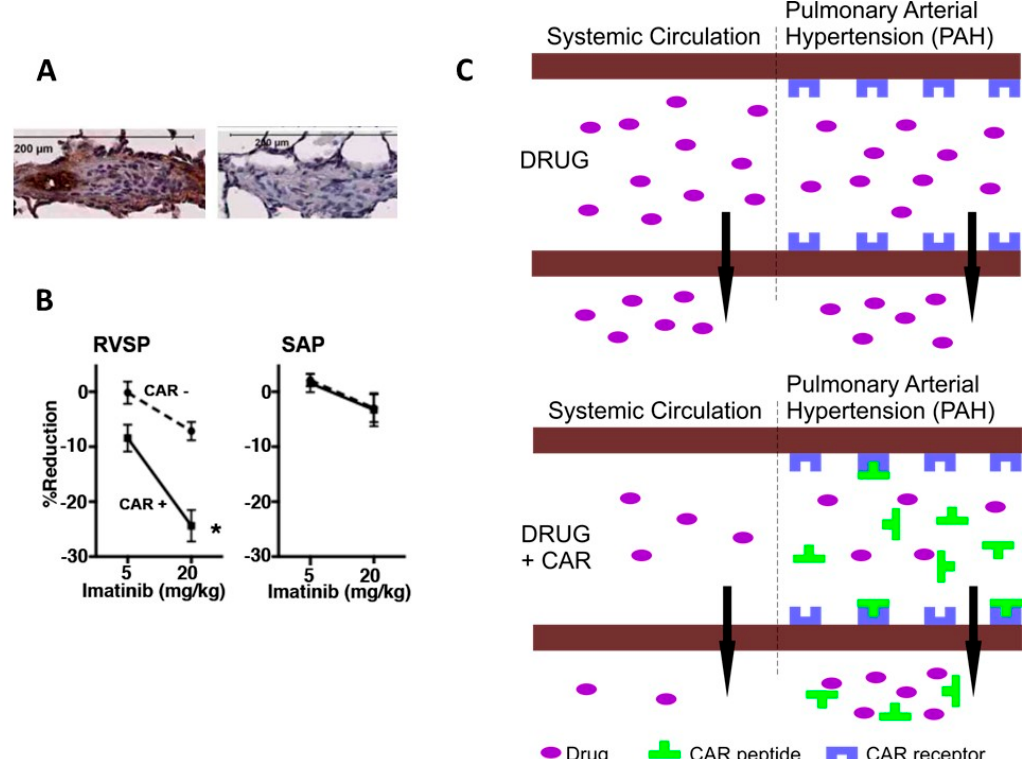
Figure 6. Vascular homing peptide induced tissue-selective vasodilation in pulmonary arterial hypertension (PAH). ( A ) Vascular homing and cell penetrating peptide CAR homes to pulmonary arteries in disease-specific fashion in experimental models of PAH [27,28]. A little bit of control peptide (mutant CAR peptide) binding can be seen to similar blood vessel in PAH. ( B ) E ff ect of CAR (0.3 mg / kg) and Rho-kinase inhibitor Y27632 (1 mg / kg) mixture on right ventricle (RVSP, right ventricle systolic pressure) and left ventricle (SAP, systemic arterial pressure) systolic pressure in PAH. The CAR / Y27632 combination treatment induced a marked pulmonary-specific vasodilation RVSP with only a minimum e ff ect on SAP in PAH. ( C ) Schematic presentation of the “bystander e ff ect”, i.e. target organ-specific drug delivery, in PAH. Reproduced from [28] with permission from Elsevier 2017.